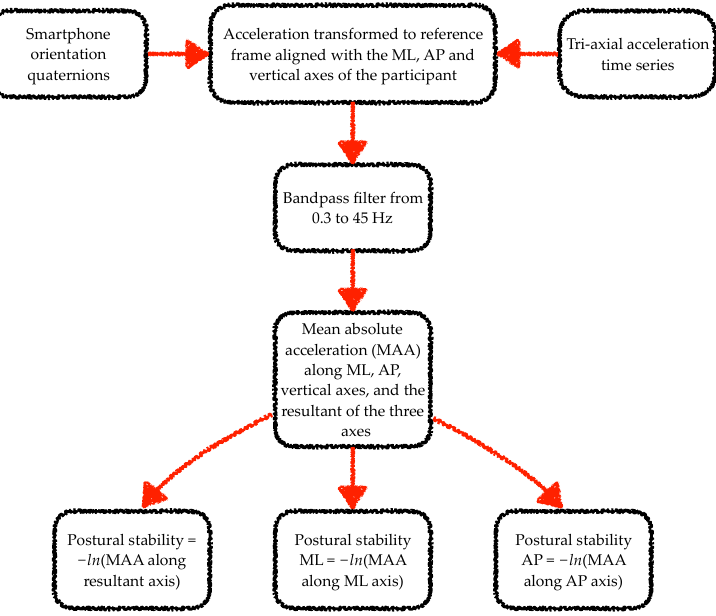
Figure 3. Flow chart of the steps involved in processing of smartphone data from the static balance tasks. Note: ML and AP stand for mediolateral and anterior–posterior, respectively. ln stands for natural logarithm.